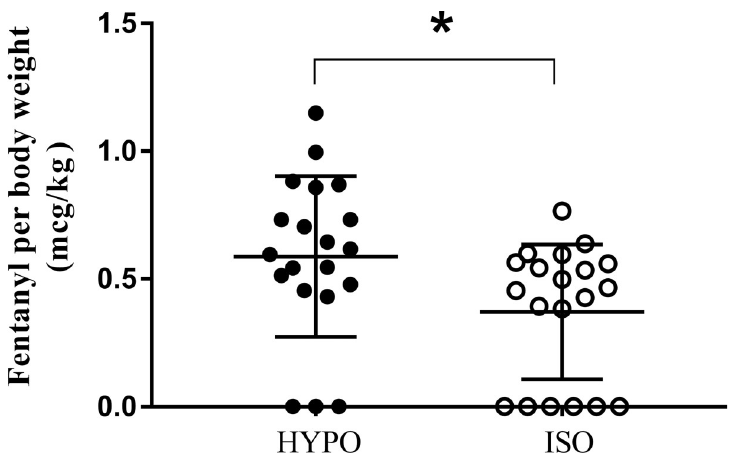
Fig 3. Fentanyl per body weight at PACU. Asterisk( � ) represents statistically significant values between the two groups.